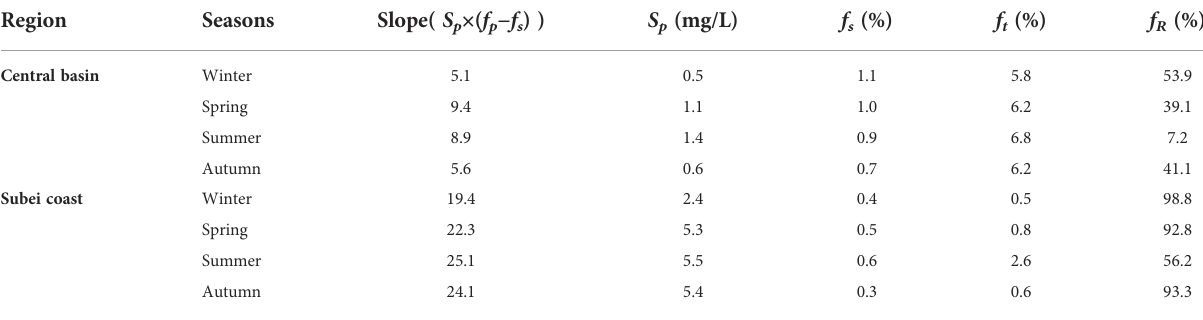
TABLE 1 Parameters used in the vertical mixing model.